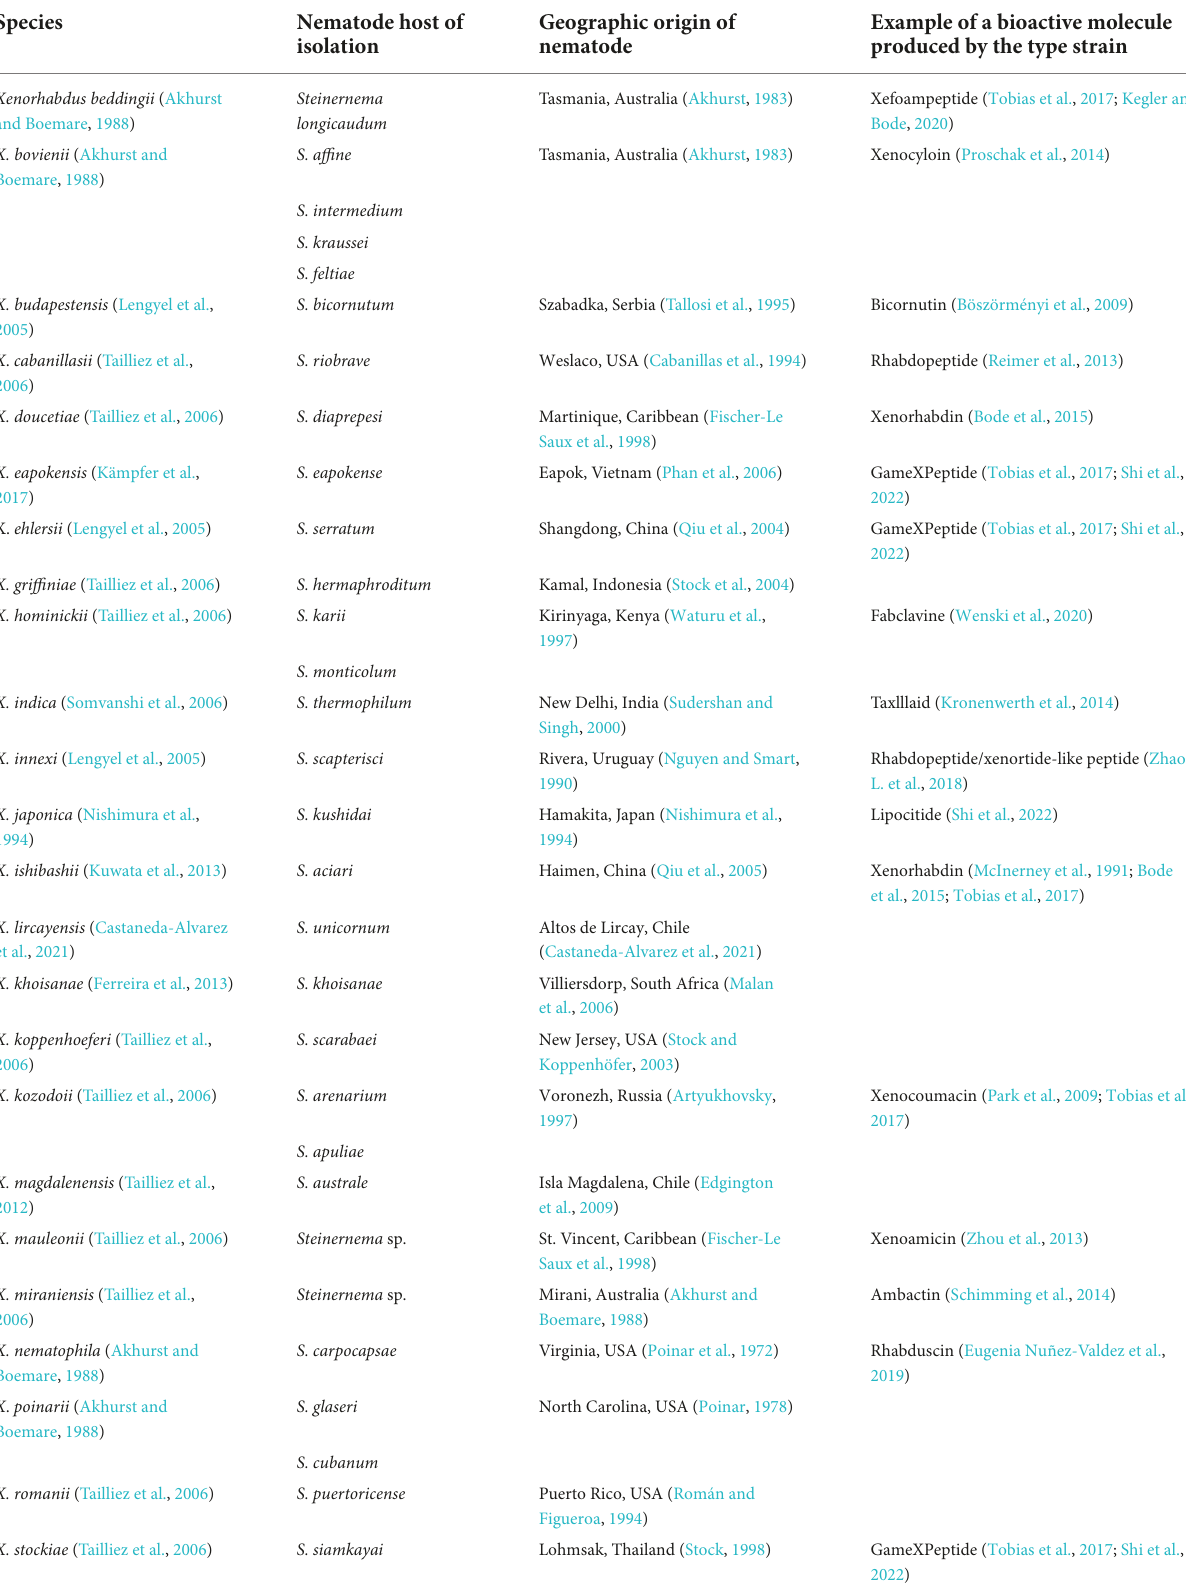
TABLE 1 Nematophilic bacteria associated with entomopathogenic nematodes (EPNs).